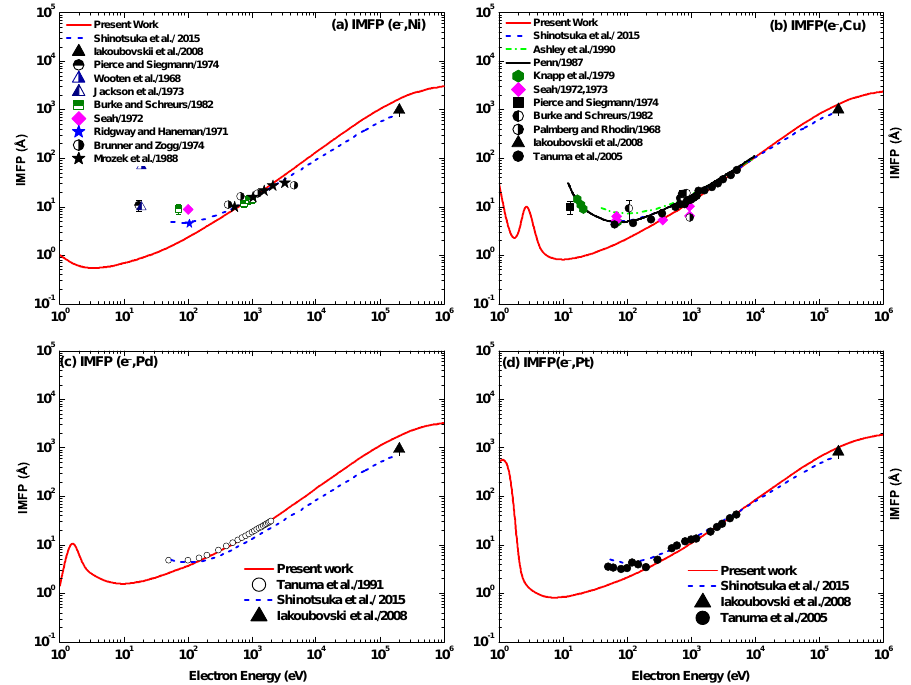
Figure 40. Inelastic mean free path λ in (IMFP) in ˙A for electrons colliding with ( a ) Ni, ( b ) Cu, ( c ) Pd, and ( d ) Pt as a function of collision energy, E i . Shown are the present results (——-, red) and the theoretical results from Shinotsuka et al. ( − − −− , blue [72]), Ashley ( − · − · − , green [74]), and Penn (in ( b ): upper full line, black [73]). Included are the experimental data from Iakoubovskii et al. [60], Pierce and Siegmann [61], Wooten et al. [62], Jackson et al. [63], Burke and Schreurs [64], Seah [66], Ridgway and Haneman [65], Brunner and Zogg [67], Mrozek et al. [68], Knapp et al. [69], Palmberg and Rhodin [70], and Tanuma et al.